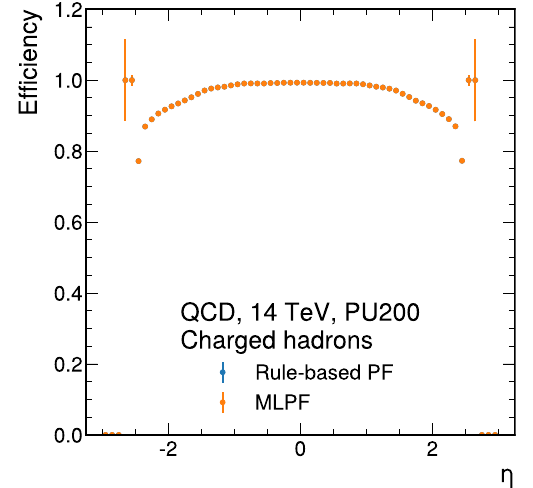
Fig. 7 The efficiency of reconstructing charged hadron candidates as a function of the generator particle pseudorapidity η in simulated QCD multijet events with PU. Since the simulation does not contain fake tracks, the charged hadron reconstruction is driven entirely by tracking efficiency and is the same for MLPF and the rule-based PF